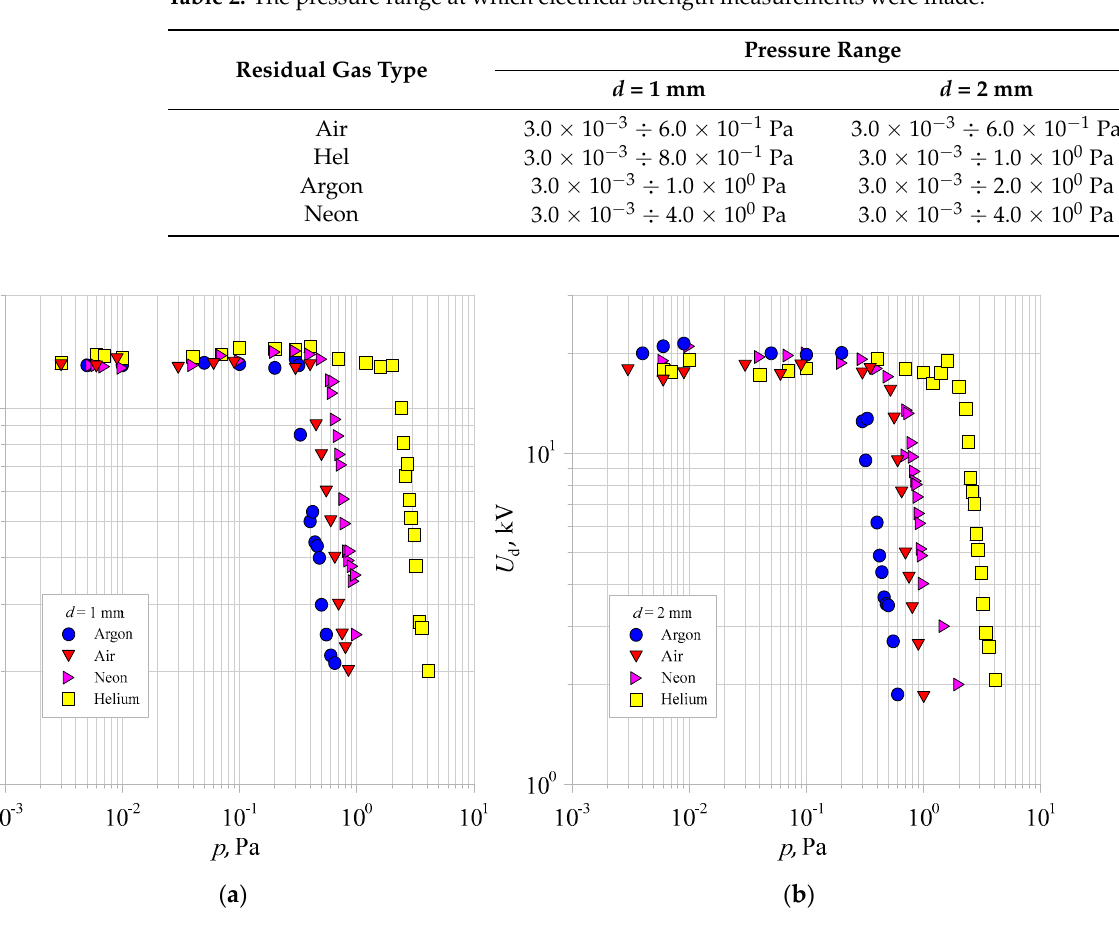
Figure 7. Dependence of the breakdown voltage U d as a function of the residual gas pressure p (argon, air, neon, and helium) for contact gaps: ( a ) d = 1 mm, ( b ) d = 2 mm.